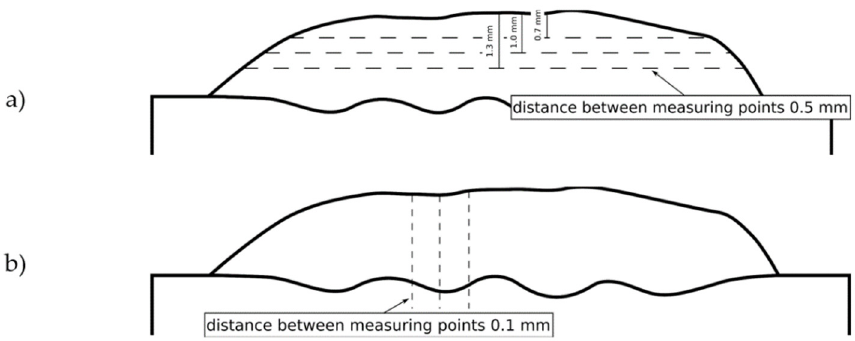
Figure 1. The Vickers microhardness measuring lines scheme, ( a ) measurements across the beads, ( b ) measurements from the coating surface to the base material. ( b ) measurements from the coating surface to the base